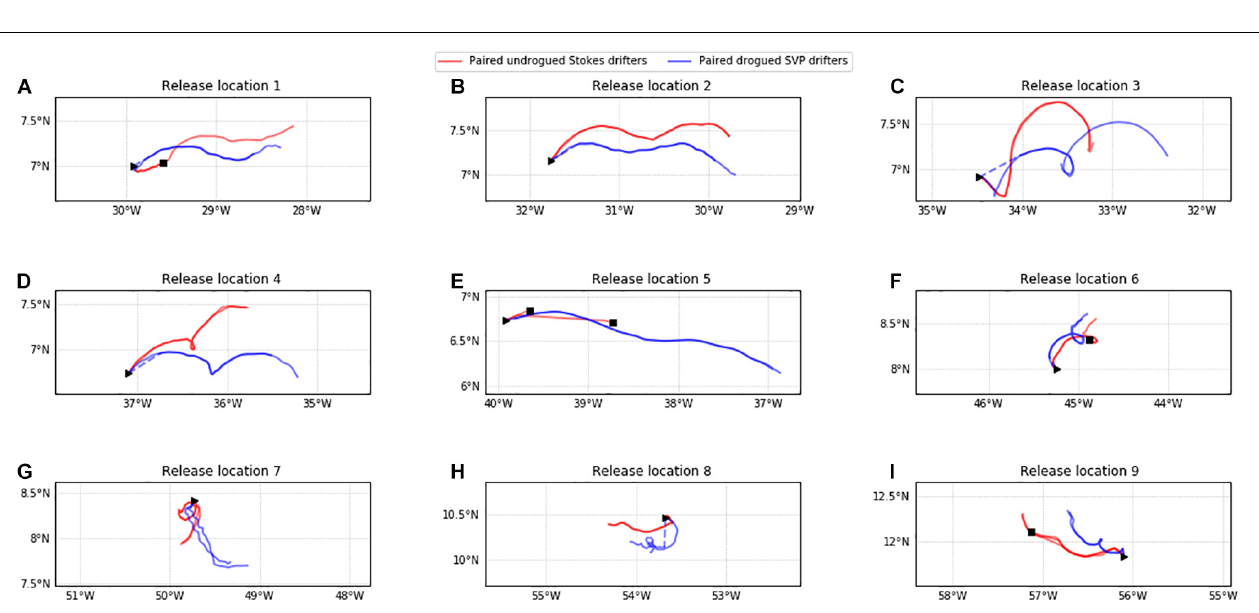
FIGURE 5 | Maps of the drifter trajectories in the first 5 days after deployment for the nine release locations from easternmost location (A) to westernmost location (I) (black triangles), with the undrogued Stokes drifters trajectories shown in red and the drogued SVP drifters trajectories shown in blue. Note that some of the SVP drifters only started transmission a few hours to a day after deployment; the displacement between the deployment location and this first transmission is indicated by blue dashed lines. Further note that not all Stokes drifters transmitted for 5 days; locations where drifters stopped transmitting are indicated by black squares.